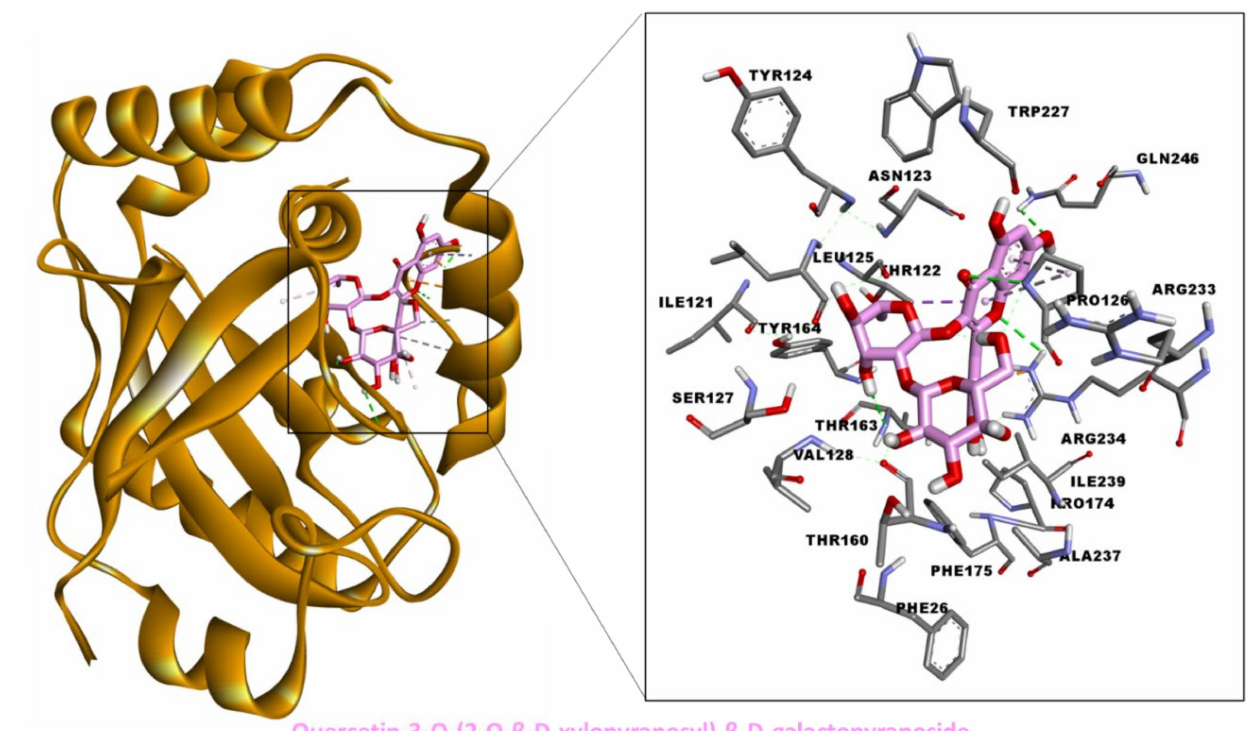
Figure 10. Interaction between HSV-1 protease and quercetin-3- O -(2- O - β - D -xylopyranosyl)- β - D -